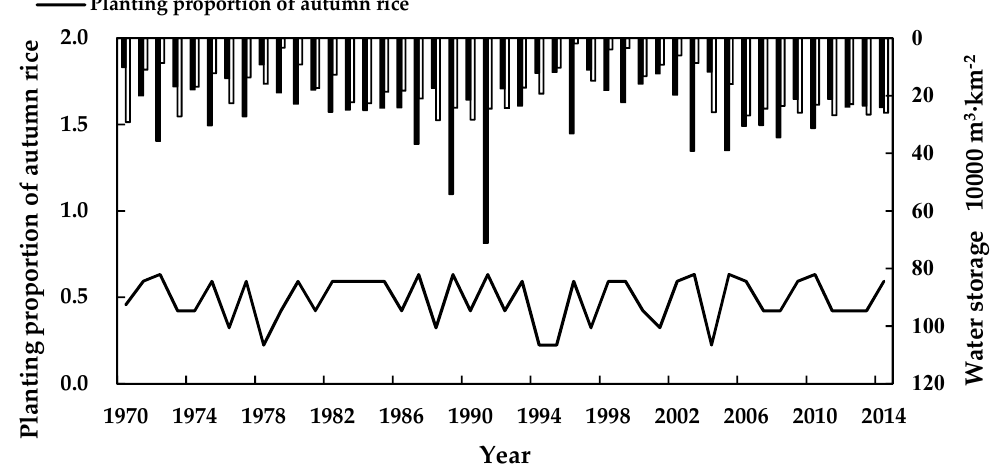
Figure 6. Annual suitable planting proportions for autumn rice under the optimal regulation mode for the pond irrigation district of Yangdain Town from 1970–2014.